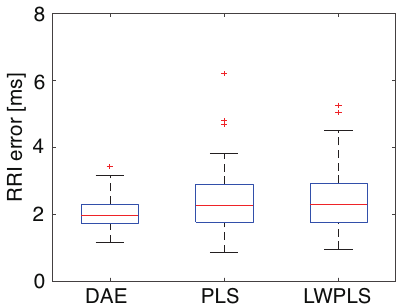
Figure 12. The RRI errors in the R wave detection error modification. Although the average RRI improvements were almost the same, the deviation of DAE was smaller than that of the other